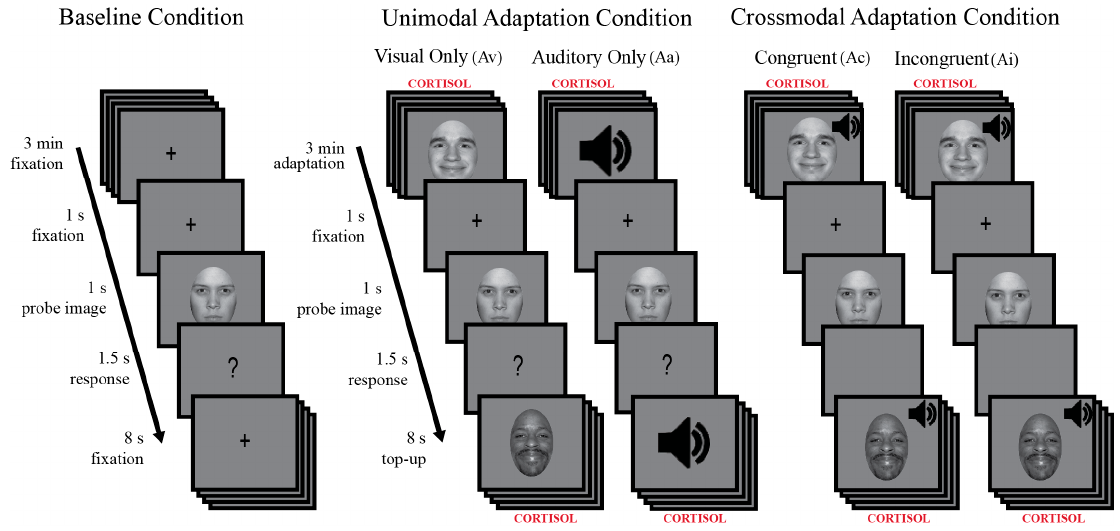
Figure 1. Experimental procedure.